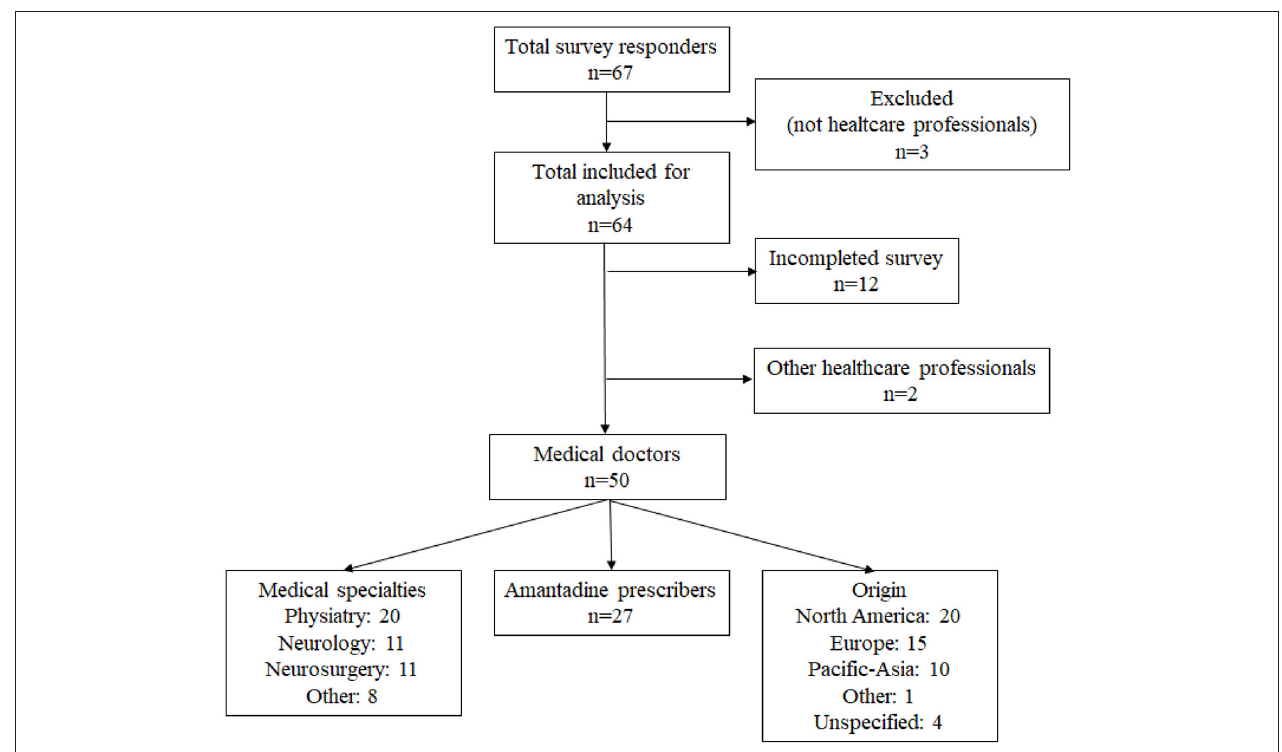
FIGURE 1 | Flowchart of the survey